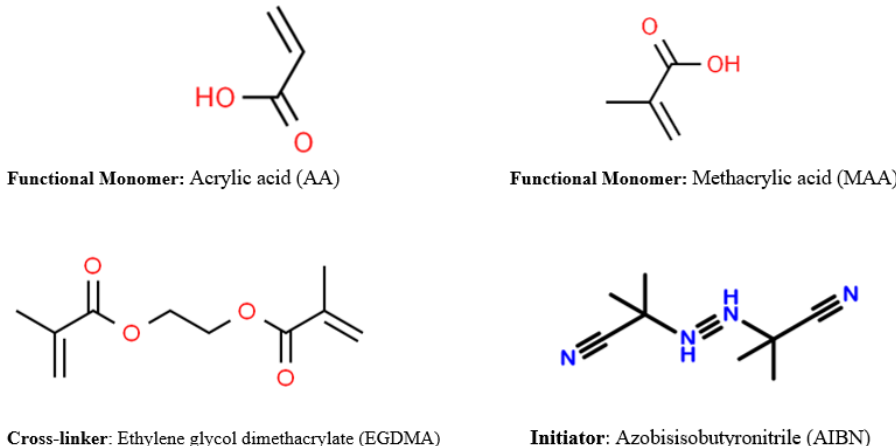
Figure 3. Some general organic molecules employed for the synthesis of molecularly imprinted pol- ymers.